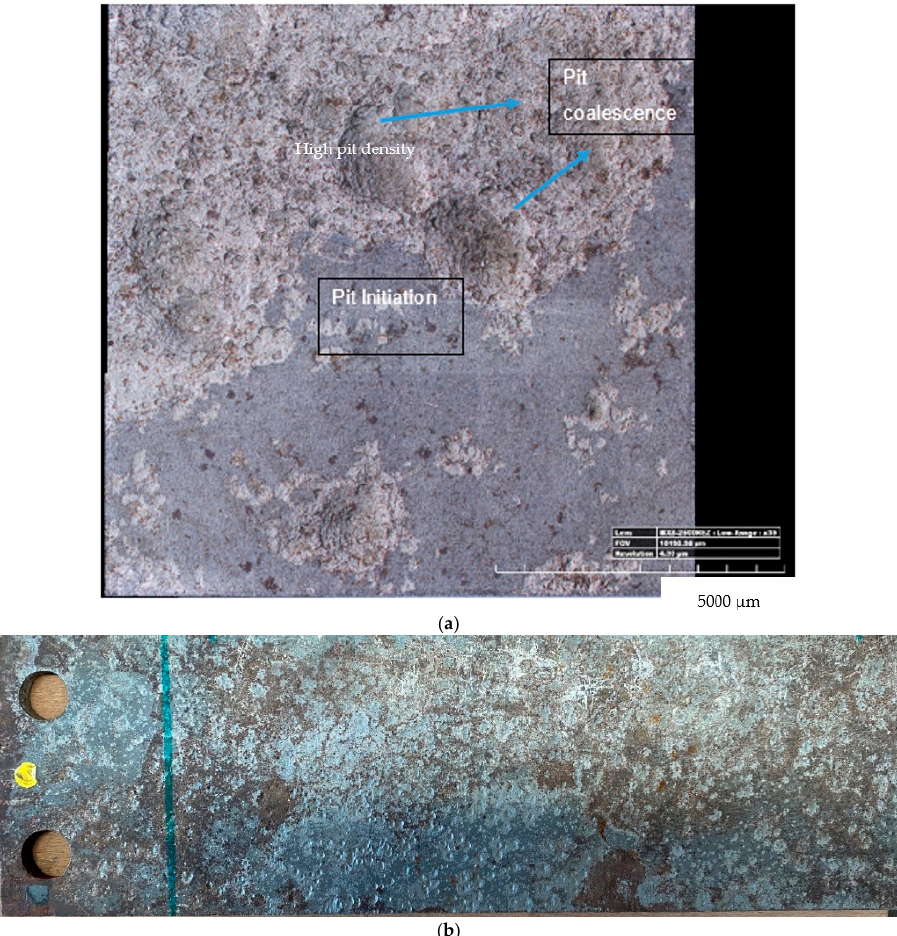
Figure 5. ( a ) Pits at different stages (from microscope image); ( b ) High pit density image.